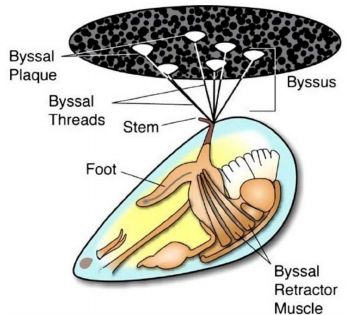
Figure 1. Anatomy of Mytilus edulis mussel and byssus structures. Reproduced with permission from Ref. [39], Copyright 2007 Springer Science + Business Media,